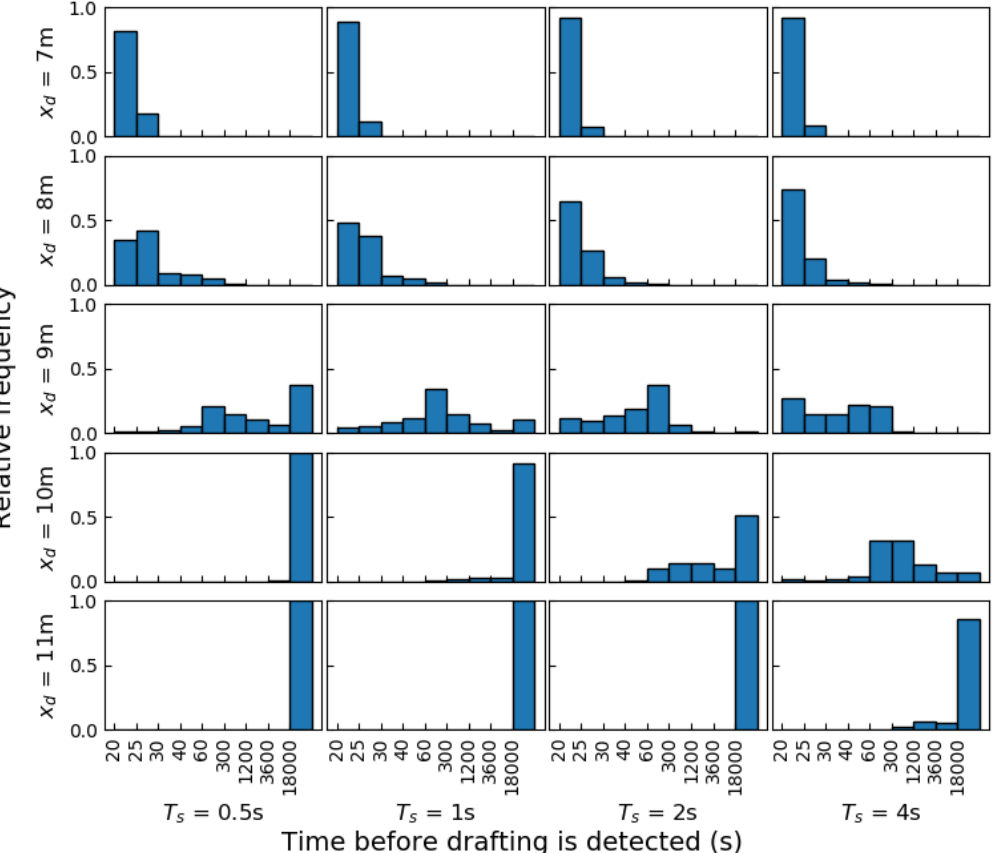
Figure 17. Histogram of time before P ( v 1: n | x 1: n ) > 0.5, with different sampling periods T s and for different distances d f . One thousand iterations were performed for every combination of distance and sampling period. Ideally, the algorithm should award a penalty after T L = 20 s of drafting, and never when the cyclist stays out of the draft